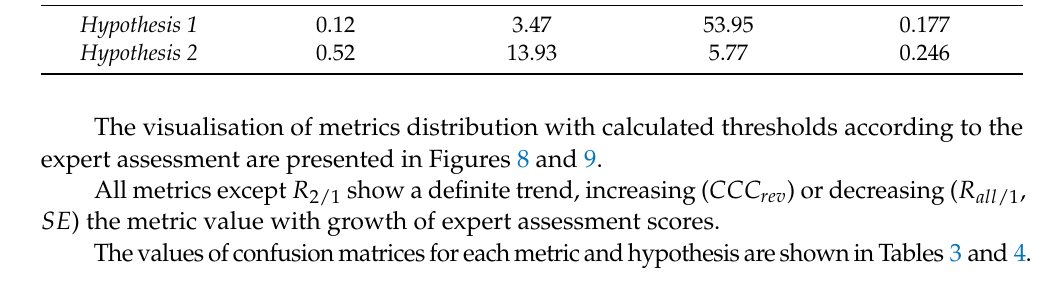
Table 3. Parameters of confusion matrices for the hypothesis 1 .